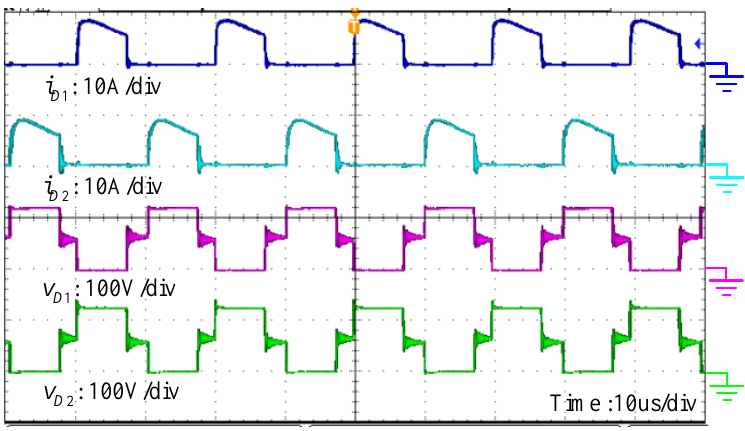
Figure 14. Measured waveforms of the voltages and currents on the output diodes.